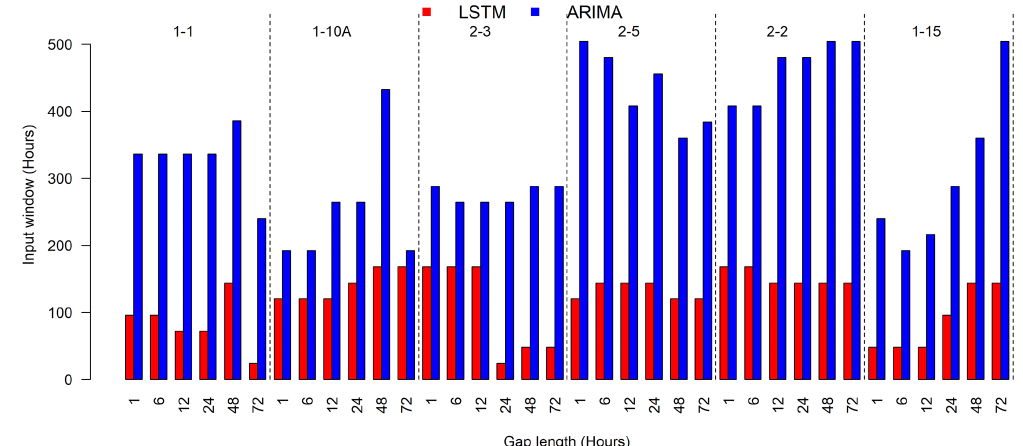
Figure 6. Optimal input windows for the LSTM and ARIMA models to fill gaps of various lengths at each well.